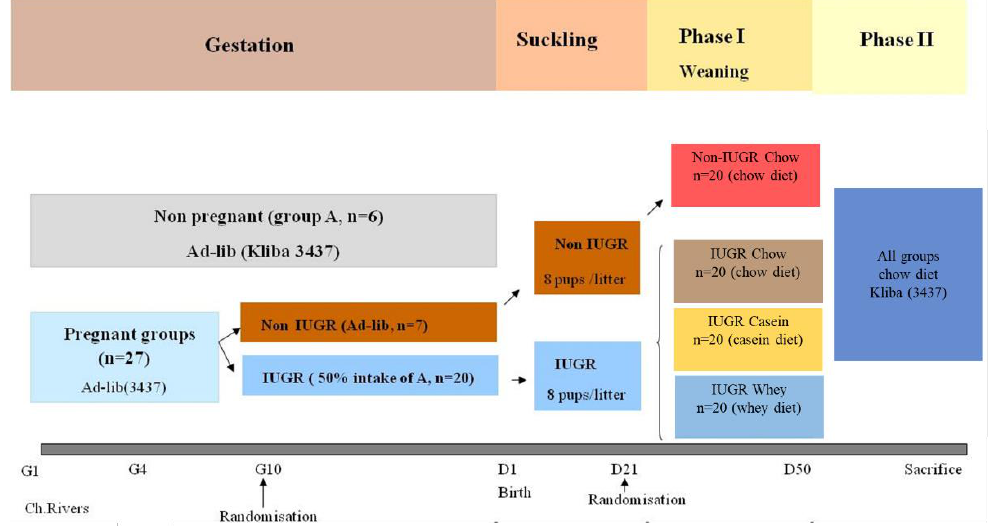
Figure 1. Study Design. Study flow chart including randomization and interventions during the prenatal, birth, and suckling periods. Ch. Rivers, Charles River; IUGR, intrauterine growth restriction; Ad-lib, ad-libitum.